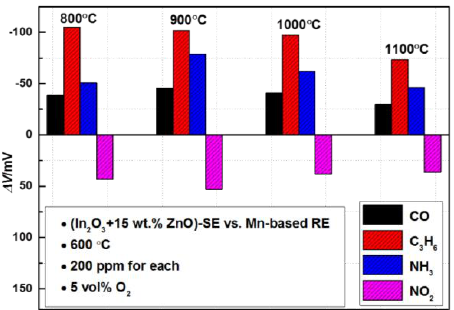
Figure 3. Influence of the calcination temperature (800–1100 °C, with intervals of 100 °C) on the sensing behavior of the sensor comprised of (In 2 O 3 + 15 wt. % ZnO)-SE, operated at 600 °C.